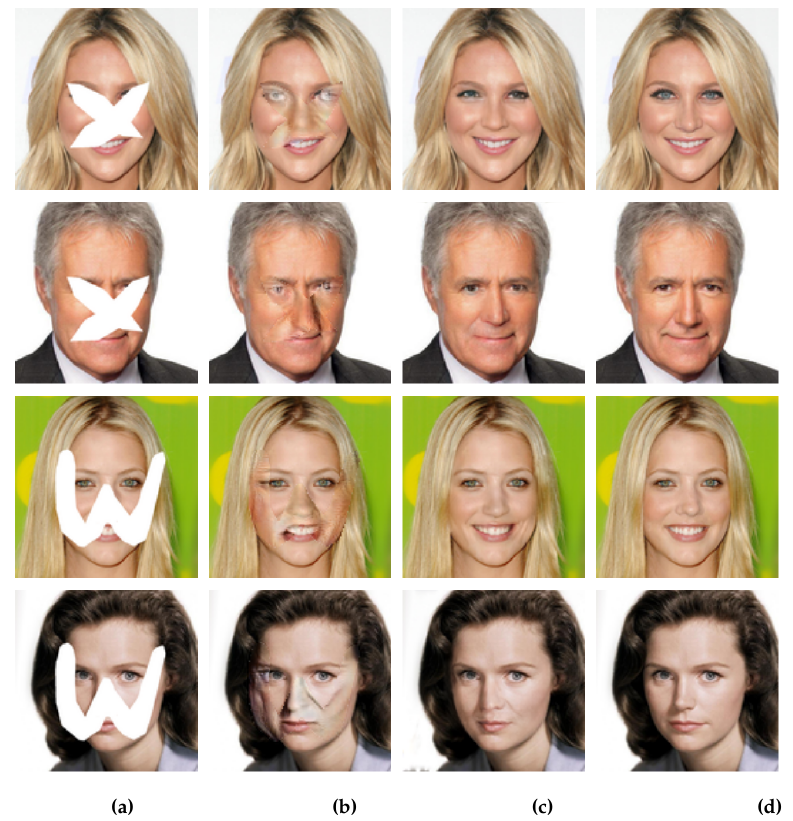
Figure 9. Completion results on the large-area irregular masks. ( a ) Masked images. ( b ) GLCIC results [8]. ( c ) Ours results. ( d ) Original